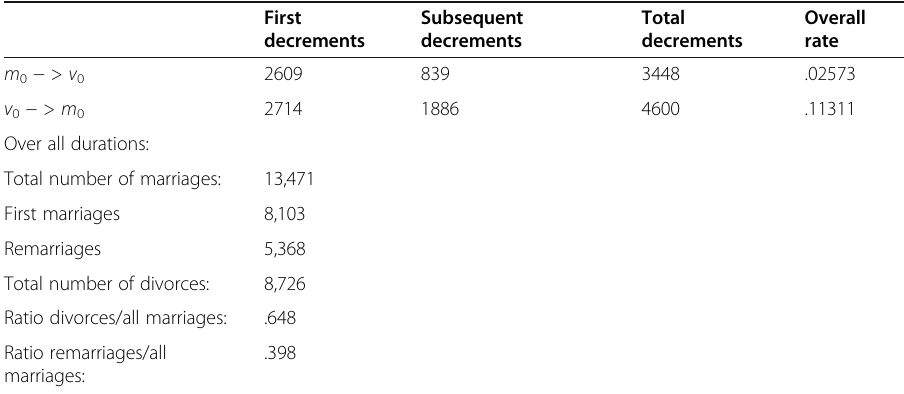
Table 6 A summary of rates and decrements in the 7 state-duration model, United States Females, 2000 – 2005, ages 30 to